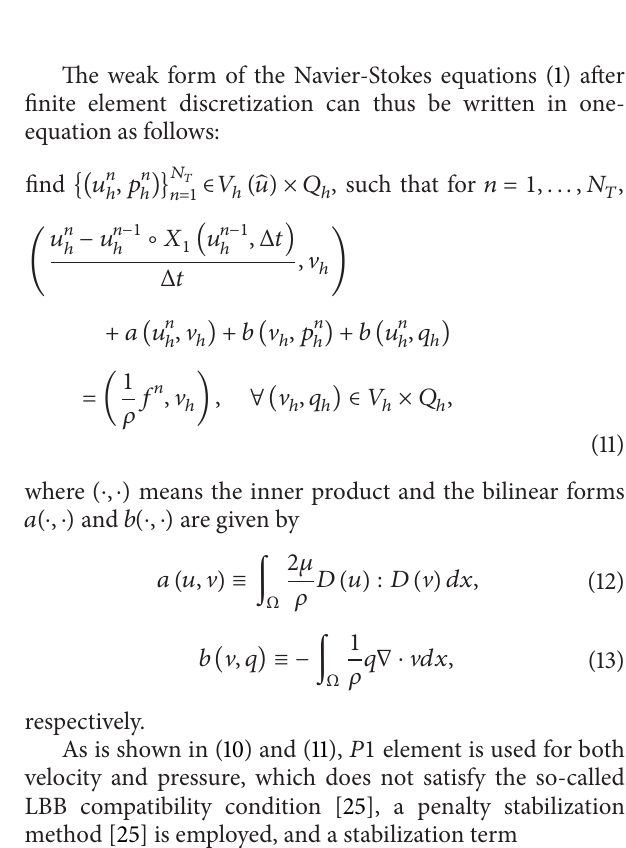
Figure 1: A moving AGV in a